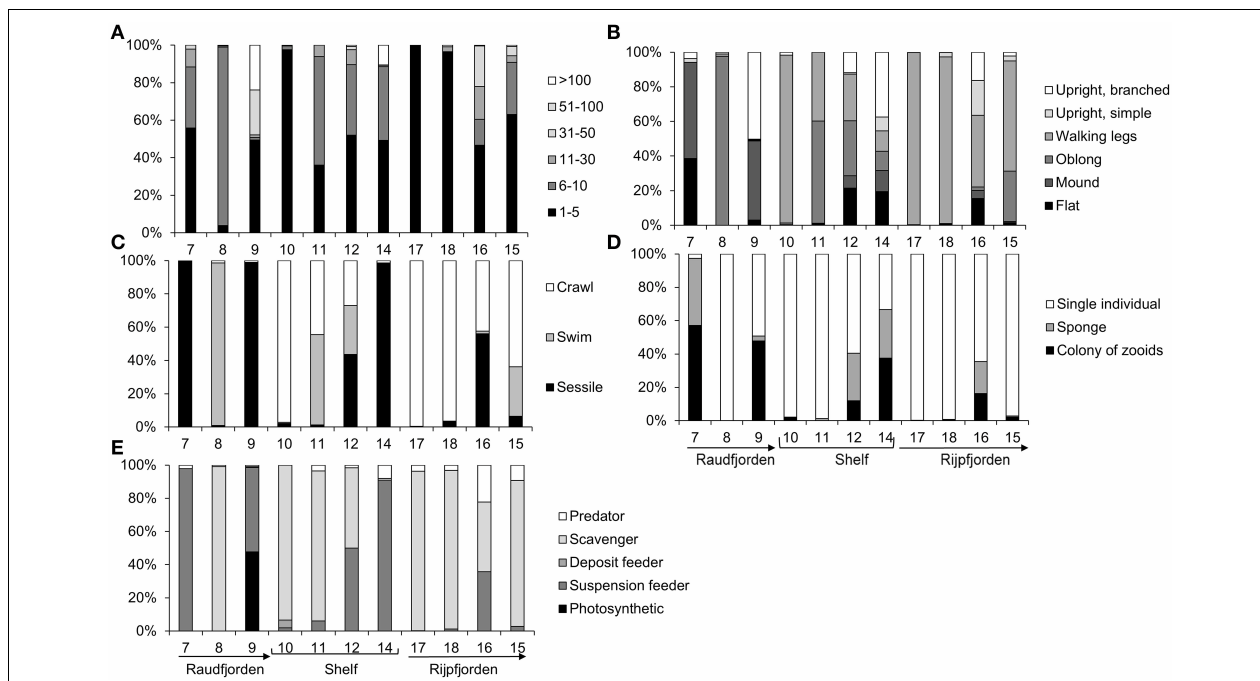
FIGURE 9 | Proportion of fauna at each north Svalbard station possessing different functional traits. (A) Size in vertically-facing view,cm, (B) basic morphology, (C) mobility, (D) colonial/solitary, (E) feeding mode. Arrows point toward mouth of each fjord.